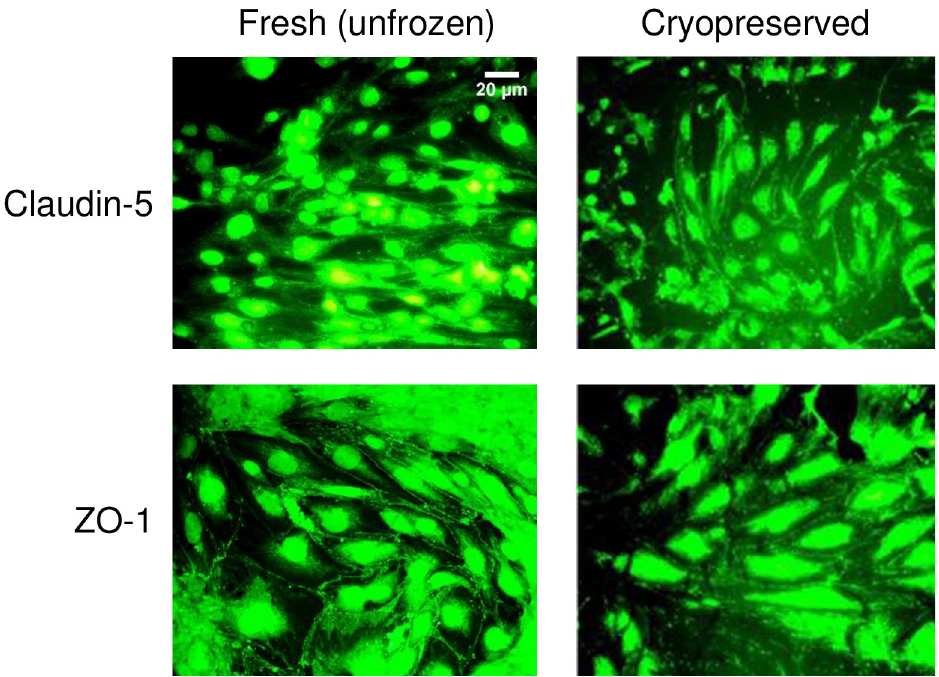
Fig 7. Junction protein expression in fresh and cryopreserved hCMEC/D3 monolayers. The expression of claudin-5 and zonula occludens (ZO)-1 in hCMEC/D3 monolayers that were non-cryopreserved (fresh, unfrozen control), or were loaded with 5% DMSO, 6% HES, and 2% chondroitin sulfate, subjected to cooling at 1˚C/min to –40˚C, plunging and storage in liquid nitrogen, rapid thawing, and immediate cryoprotectant removal. Fresh and cryopreserved monolayers were stained with the corresponding antibody conjugated to Alexa Fluor 488. The scale bar for claudin- 5-stained fresh, unfrozen cells applies to all images.